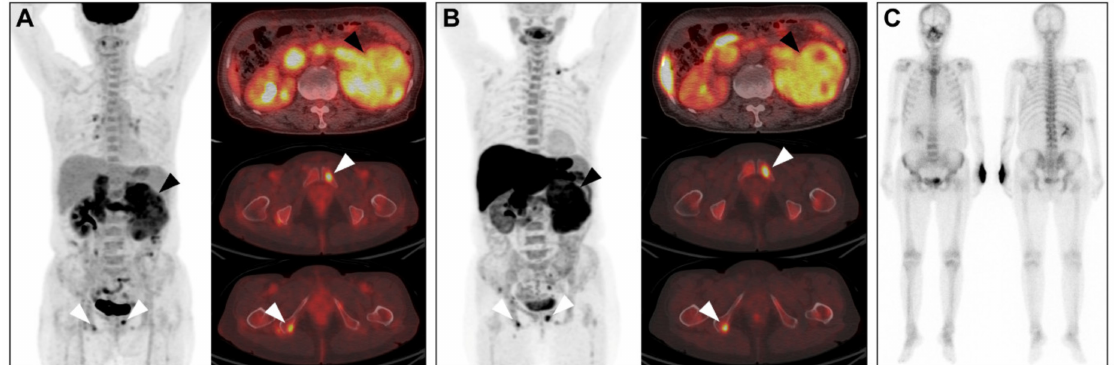
Figure 2. RCC with high MTV. A 66-year-old female had a renal mass (black arrowhead) with high F-18 FDG uptake (( A ) SUV max : 7.64, MTV: 515.38 cm 3 ) and high C-11 MET uptake (( B ) SUV max : 9.93, MTV: 424.01 cm 3 ). ( C ) Bone metastases (white arrowhead) were also noted on F-18 FDG and C-11 MET PET/CT but were not well-noted on the whole-body bone scan. A 13.0-cm-sized Fuhrman grade 3 clear cell carcinoma was reported after surgery, and the pathological stage was IV (T4 N1 M1). RCC, renal cell carcinoma; FDG, fluorodeoxyglucose; MET, methionine; SUV max , maximum standardised uptake value; MTV, metabolic tumour